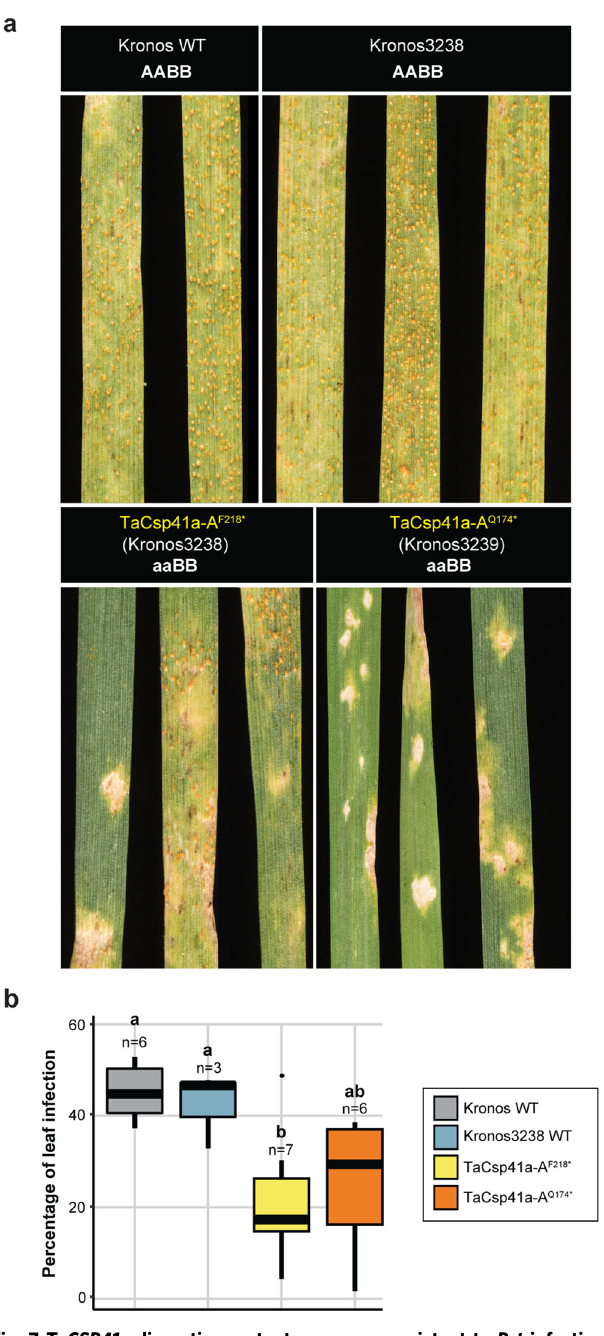
Fig. 7 TaCSP41a disruption mutants are more resistant to Pst infection. a TaCSP41a-A F218 * and TaCSP41a-A Q174 * disruption mutants are more resistant to infection by Pst isolate 13/14 compared to the Kronos wild type (WT) or the Kronos ethyl methanesulfonate (EMS) mutant Kronos3238 carrying a WT allele at TaCSP41a . Images were captured at 20 dpi. b Lower rates of leaf infection in the TaCSP41a-A disruption mutants at 20 dpi, represented as box and whiskers plots. Lowercase letters denote statistically signi fi cant differences by Duncan ’ s multi-range test ( p < 0.05). Horizontal bars, median values; boxes, upper (Q3) and lower (Q1) quartiles; whiskers, 1.5 × the inter-quartile and only small necrotic regions in all plants tested. Together, these results demonstrate that disrupting TaCSP41a-A function promotes tolerance to Pst 13/14, indicating a role for TaCSP41a in supporting Pst disease progression.